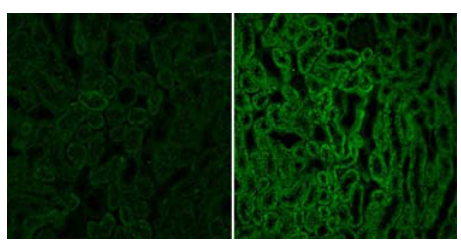
FIGURE 2. Representative microscopic pictures of immunohistochemical staining for the AT2 receptor in paraffin kidney sections in control (left) and diabetic (right) C57Bl6 mice. Magnification, ×